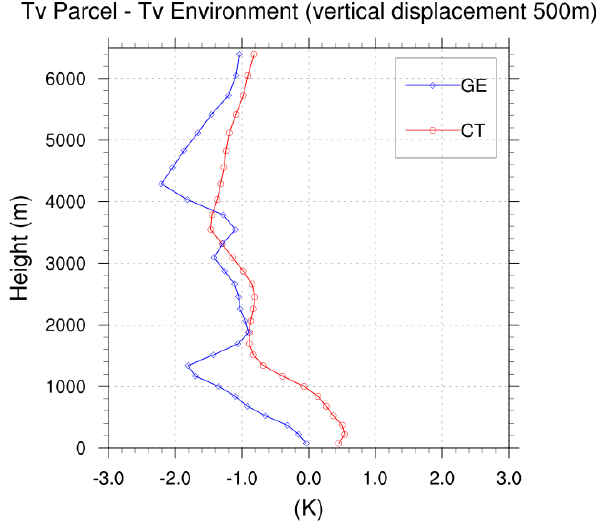
Figure 13. Profiles of virtual temperature difference between an air parcel raised to a height of 500m above its initial position (vertical axis) and the environment at the final height, for the same experi- ments of Fig. 12. Red: CT case, valid at 12:00UTC of 25 October, averaged in a square of 0.5 ◦ side, centred at the small red circle in Fig. 12b. Blue: GE case, valid at 09:00UTC of 4 November, centred at the small red circle in Fig.